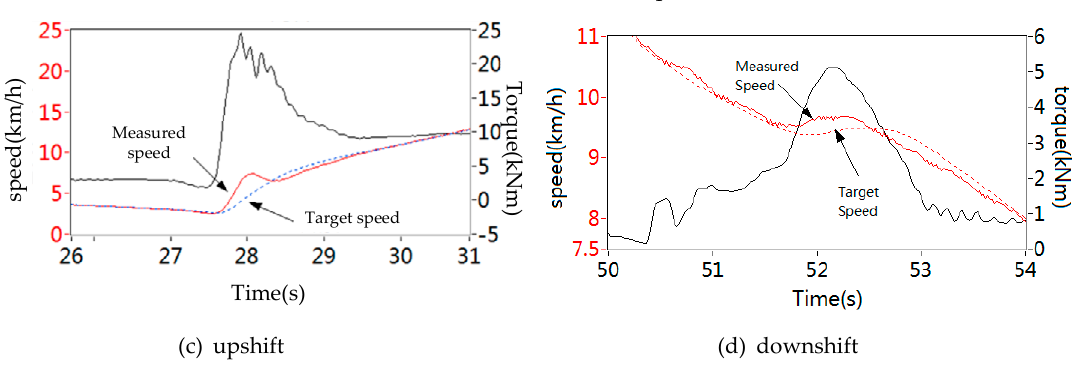
Figure 29. Load and shift